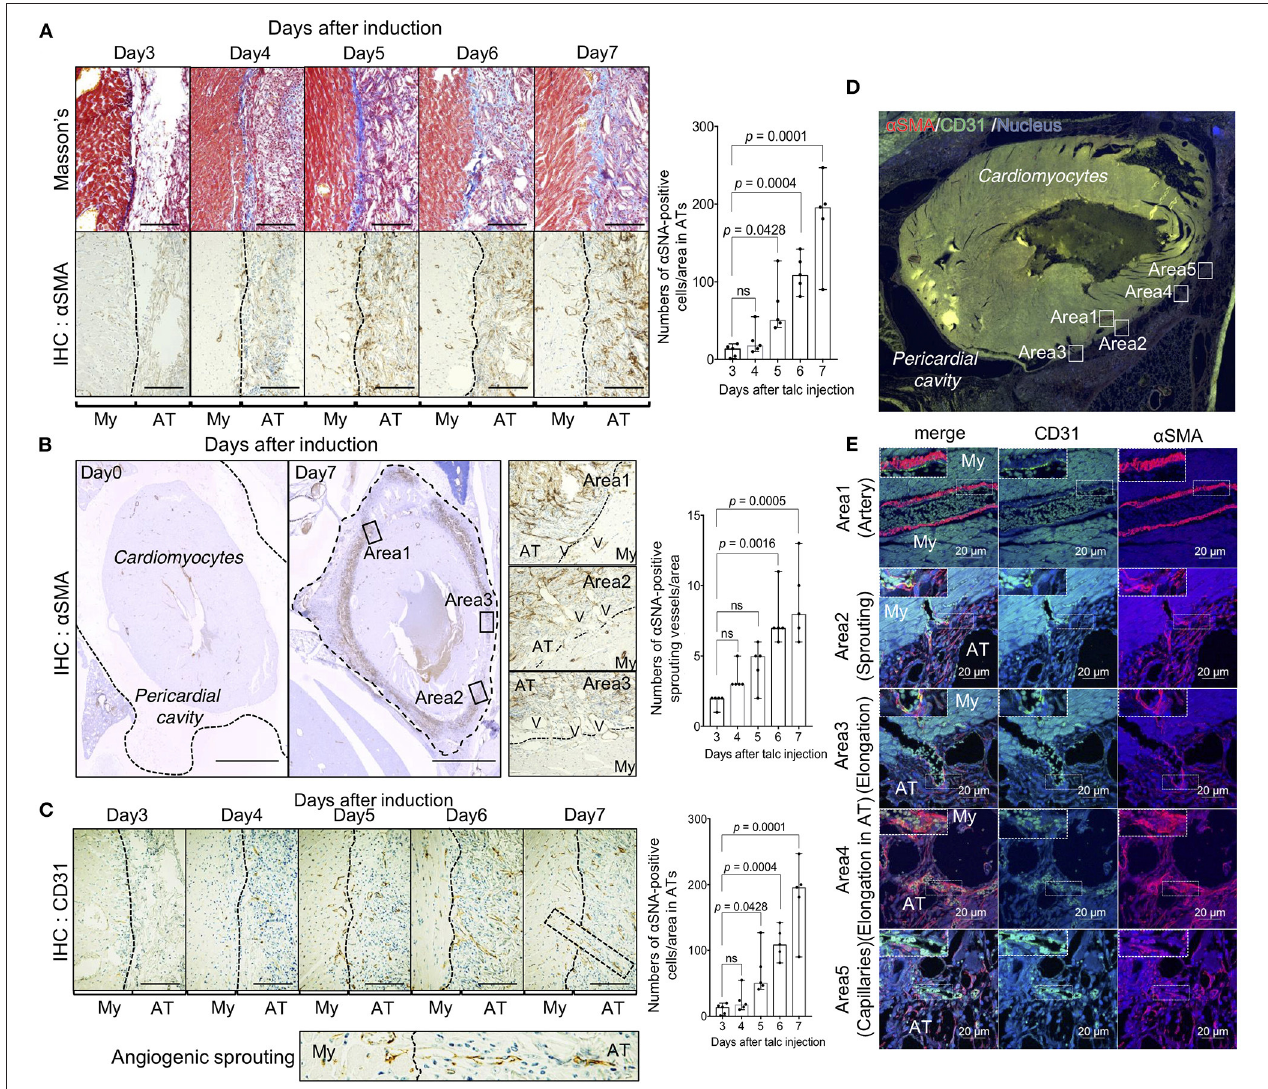
FIGURE 2 | Unique angiogenic process from the heart during pericardial adhesion. (A) The left panels show the results of Masson’s trichrome staining and α -SMA immunohistochemistry (IHC). The broken lines indicate the borders between myocardial (My) and adhesion (AT) tissues. Bar = 50 µ m. The right panel shows quantified α SMA-positive cells in adhesion tissues ( n = 5). Data are presented as means ± SE. Statistical analyses were performed using one-way ANOVA with Dunnett’s multiple comparison test (parametric variables). (B) Left panels show the whole heart view of α SMA IHC before and after talc injection. The broken lines on day 0 indicate the pericardium. The middle panels show magnified views of areas 1–3 in the left panels. The broken lines indicate the borders between myocardial (My) and adhesion (AT) tissues. V indicates the presence of a vascular-like structure. Bar = 1mm. The right panel shows quantified cell numbers of α SMA-positive bridging structures between myocardial and adhesion tissues ( n = 5). Data are presented as means ± SE. Statistical analyses were performed using Kruskal-Wallis test with Dunn’s multiple comparison test (non-parametric variables). (C) Tissue localization of CD31-positive endothelial cells. The lower panel shows an enlarged view of the sprouting vessels from myocardial tissues to adhesion tissues surrounded by broken lines in the upper right image. Bar = 50 µ m. The right panel shows quantification of CD31-positive sprouting vessels per area in the pericardial surface ( n = 5). Data are presented as means ± SE. Statistical analyses were performed using Kruskal-Wallis test with Dunn’s multiple comparison test (non-parametric variables). My, myocardium; AT, adhesion tissue. (D) Immunofluorescence of whole heart stained using anti- α SMA ( red ) and CD 31 ( green ) antibodies. Nuclei were stained with Hoechst stain ( blue ). Bar = 1mm. (E) Magnified views of areas 1–5 in (D) , representing quiescent, sprouting, and elongating blood vessels. Upper left dotted boxes in (E) show an enlarged view in the areas surrounded by broken lines. Bar = 20 µ m. My, myocardium; AT, adhesion